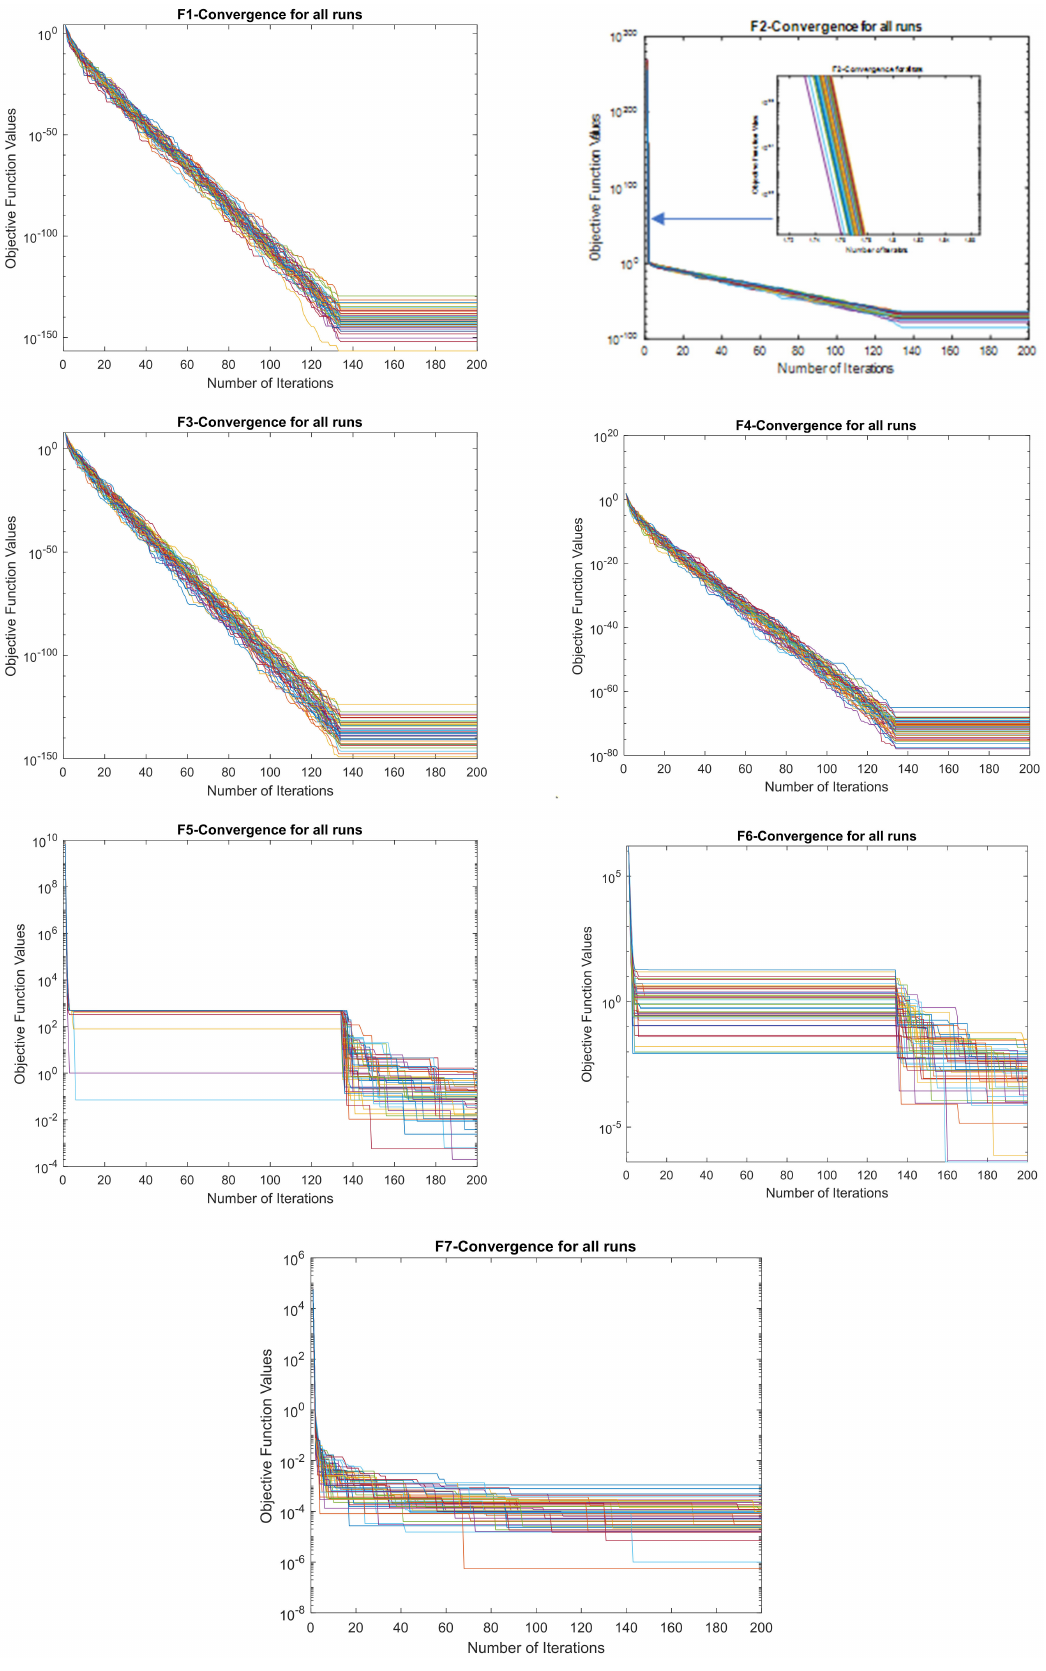
Figure 11. Convergence of MAO over 50 trials for unimodal functions of 50-dimensional